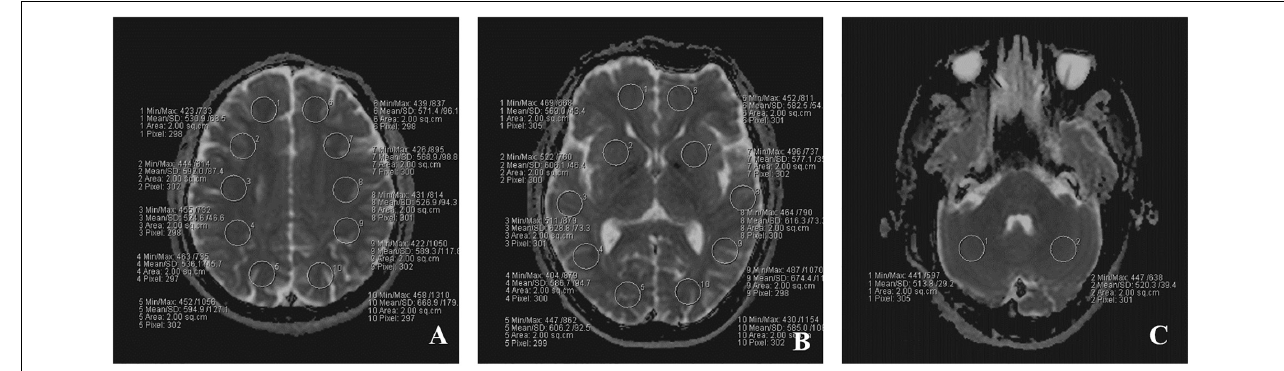
FIGURE 2 | The placement of ROIs on IVIM images in three different level. (A) peripheral white matter level; (B) basal ganglia level; (C) cerebellar hemisphere level. A total of 22 ROIs were placed symmetrically on the three transverse images.